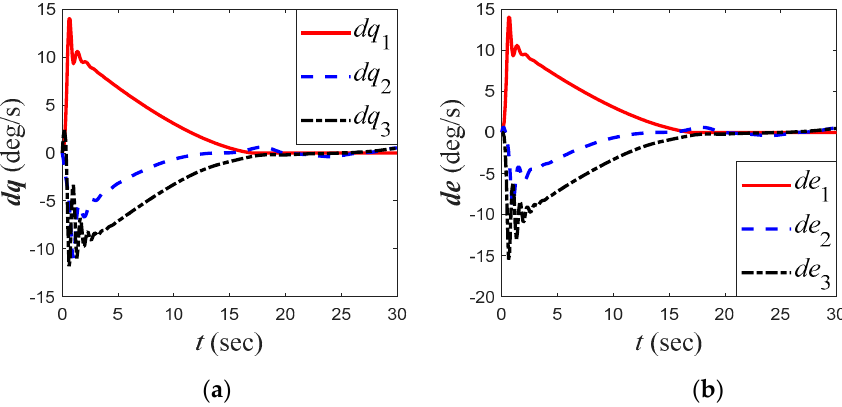
Figure 7. ( a ) Joint angular velocities; ( b ) Joint angular velocity tracking errors.